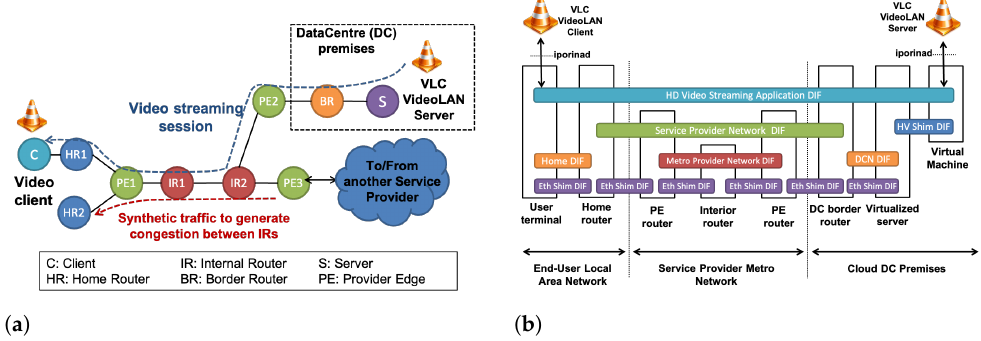
Figure 7. The RINA experiment network: ( a ) The 10-node infrastructure; ( b ) The configuration of the